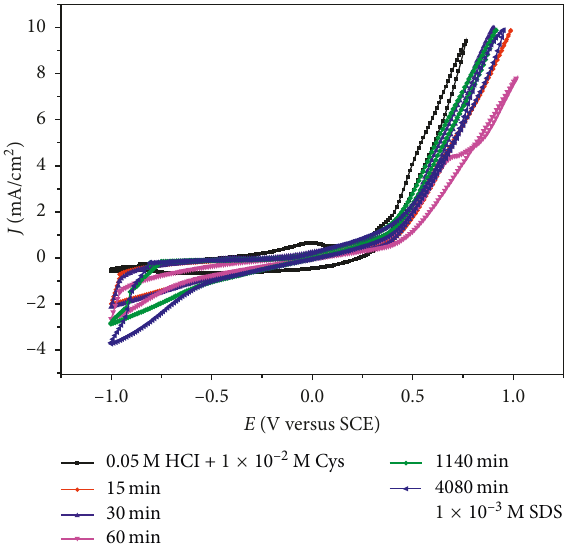
Figure 7: Cyclic voltammogram of brass in 0.05M HCl +1 · 10 − 2 M cysteine solution after electrode immersion in 1 · 10 − 3 M SDS so- lution for various periods of time (15, 30, 60, 1200, and 4080min; scan rate: 10mV/s).